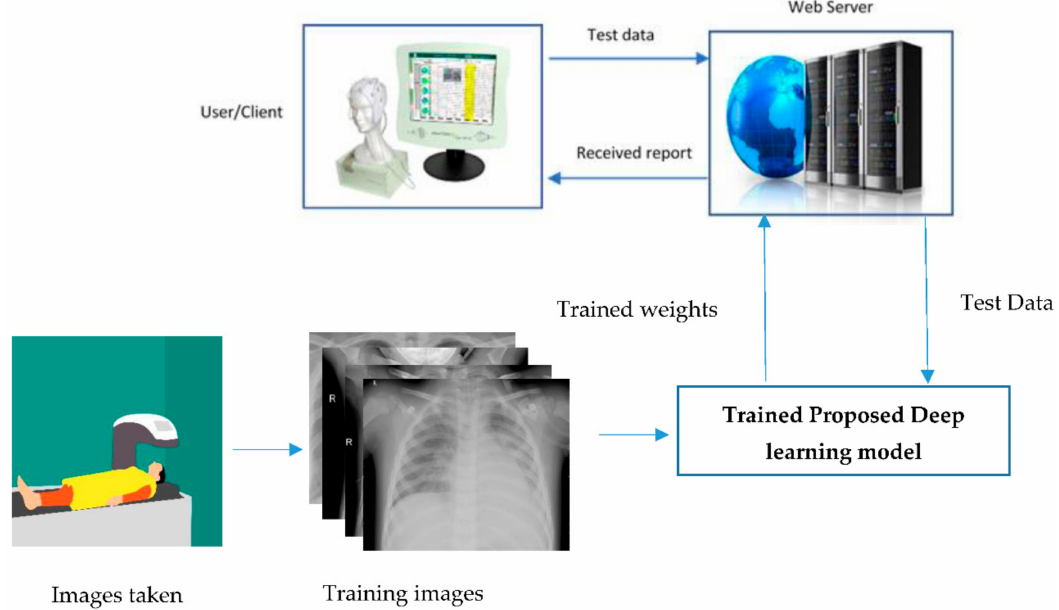
Figure 12. Deployed proposed deep-learning model for assessment and detection of COVID-19 in clinical